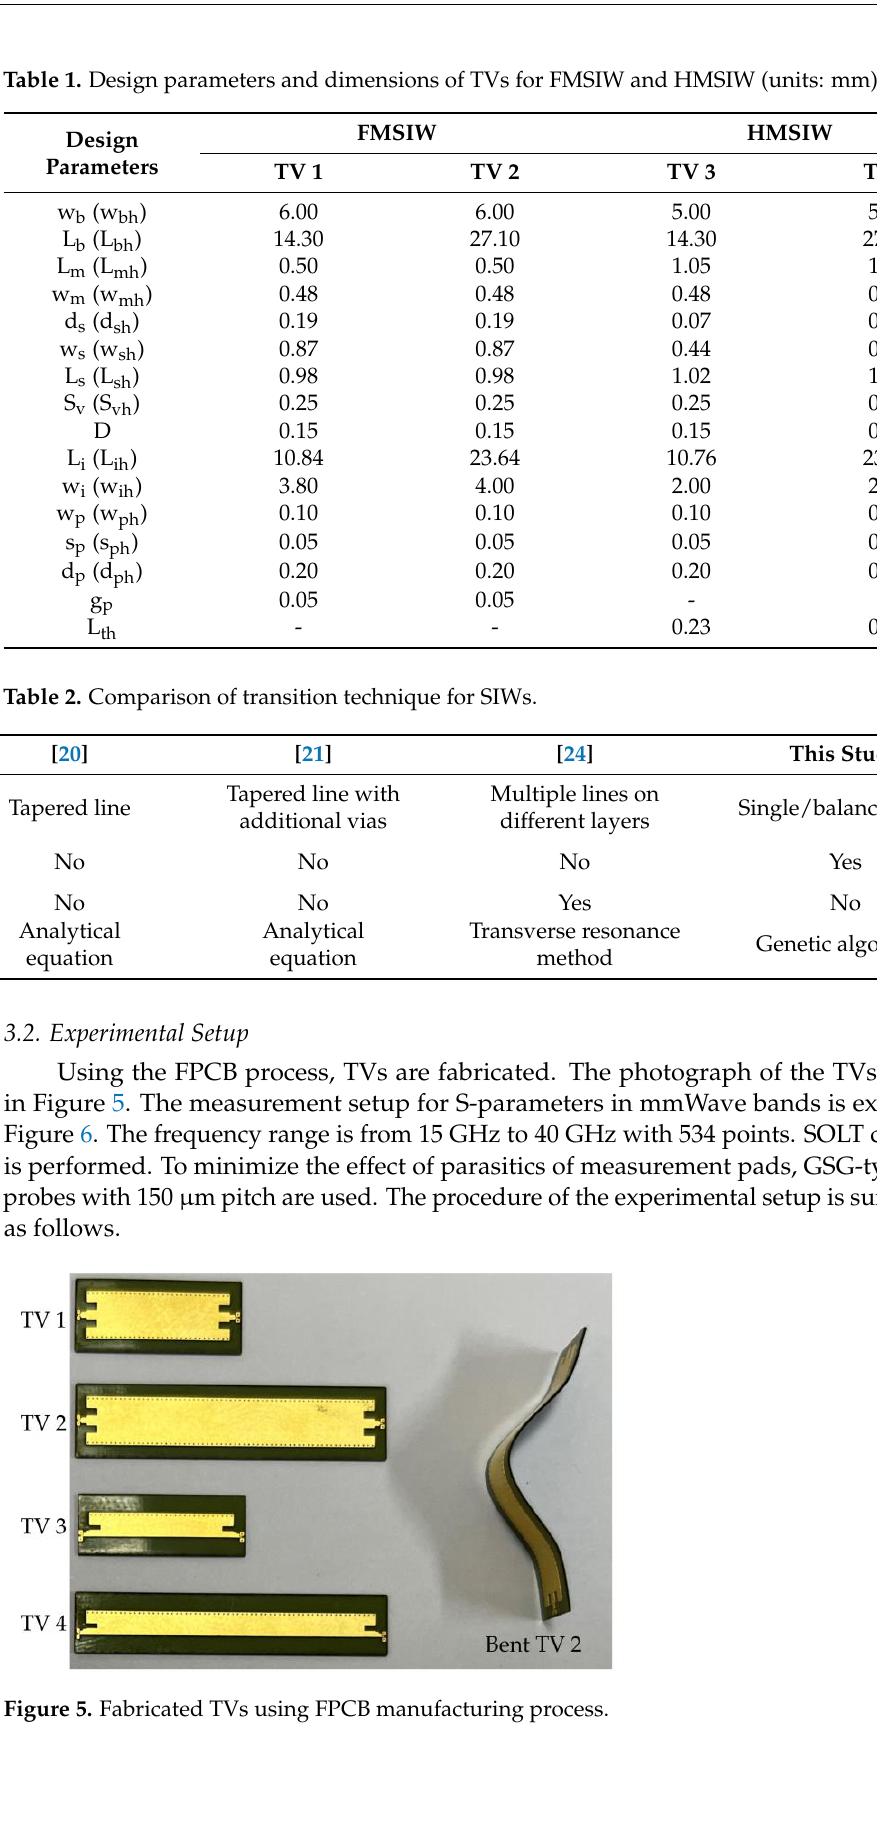
Figure 6. Measurement setup for S-parameters with a vector network analyzer and microprobes. 1.